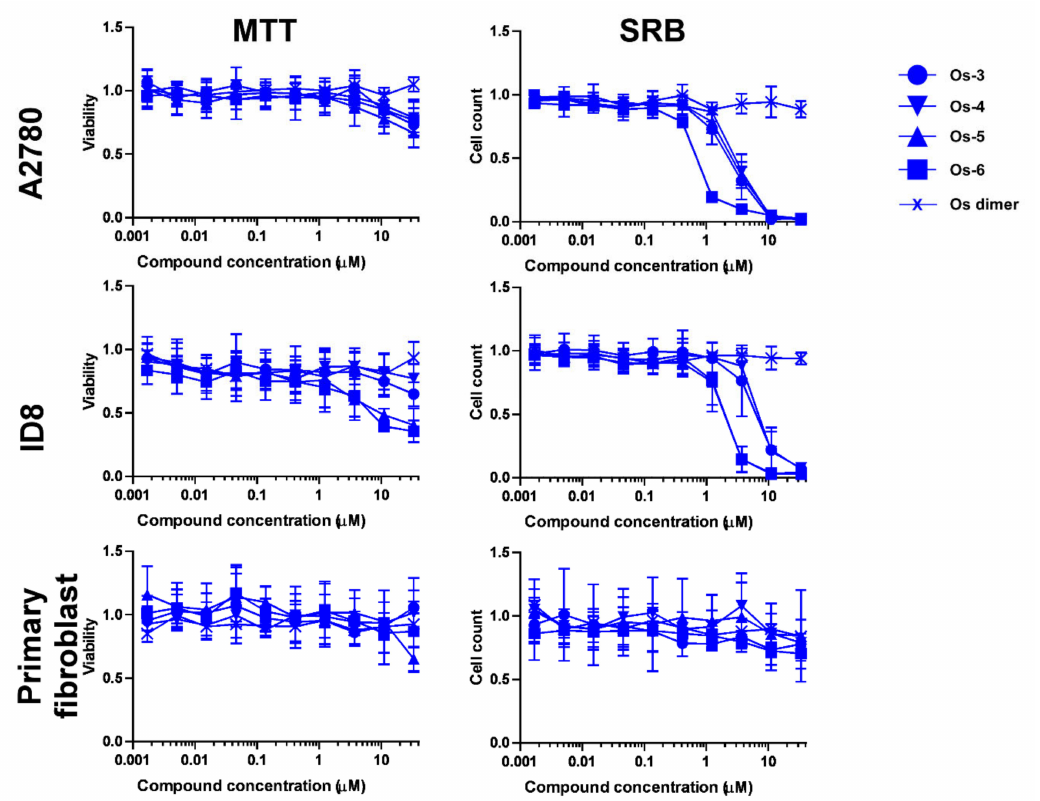
Figure 5. Assessment of the osmium complexes Os-3-Os-6 for cytotoxic and cytostatic activity. Briefly, 3 × 10 3 A2780 cells, 2 × 10 3 ID8 cells, and 4 × 10 3 primary fibroblasts were plated onto 96-well plates. Cells were treated with the compounds in the concentrations indicated for either 4 h for an MTT assay or for 48 h for an SRB assay. Data are represented as average ± SD, from three biological replicates (in SRB assays for ID8, five biological replicates were used); individual assays were performed in duplicate. Values were normalized for vehicle-treated cells; absorbance for vehicle-treated cells is equal to 1. A one-way ANOVA, followed by a Kruskal-Wallis test, was performed individually for each compound. The results of the statistical analysis are presented in an Excel spreadsheet at https://figshare.com/s/28d14597d5041f08eb08 (accessed on 6 January 2022). Nonlinear regression was performed on the